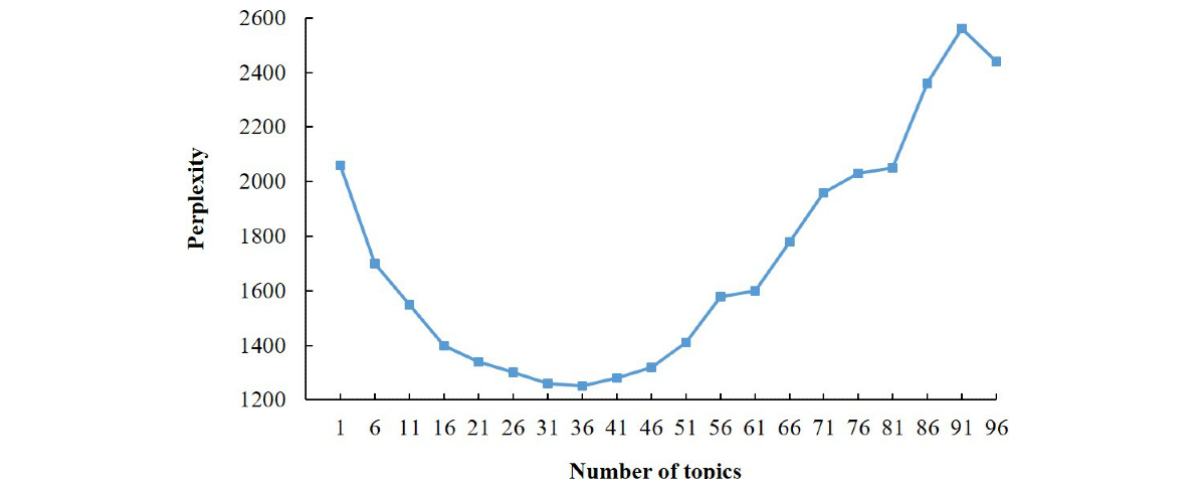
Figure 6. Latent dirichlet allocation model topic number in a perplexity